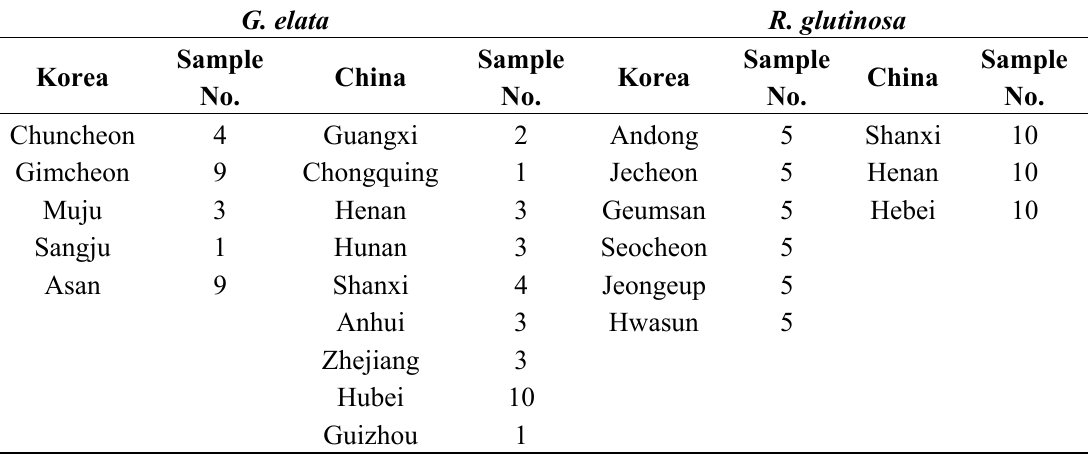
Table 6. Sample collected regions of two herbal medicines in Korea and